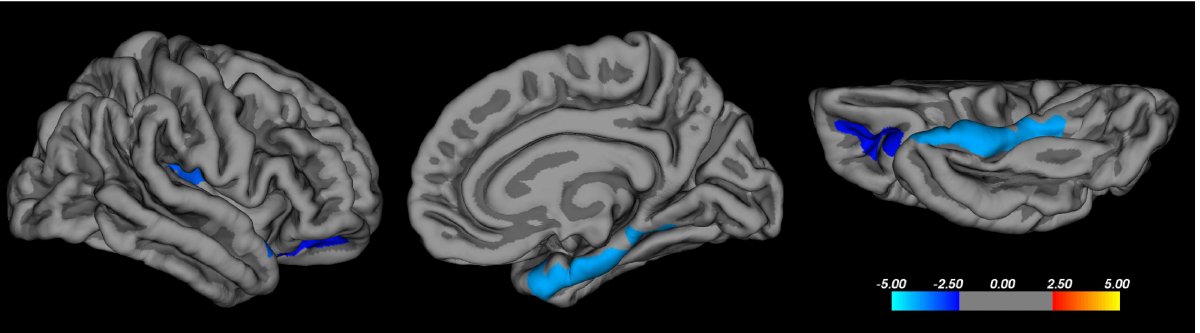
Fig 2. Cortical thickness and Hayling error score correlations. Correlations between cortical thickness and total error score on the Hayling test in patients with behavioural variant frontotemporal dementia and progressive supranuclear palsy using Freesurfer. Correction for multiple comparisons was made using the Monte Carlo method at the cluster level, at p < 0.01 (z-vertex 1.3). Age was entered as a nuisancevariable. Colouredareas represent significant negative correlations, with the scale bar representing p on a logarithmicscale. Only the right hemisphere is shown, from lateral, medial and inferior views. No regions with significant correlationwith cortical thickness were detected in the left